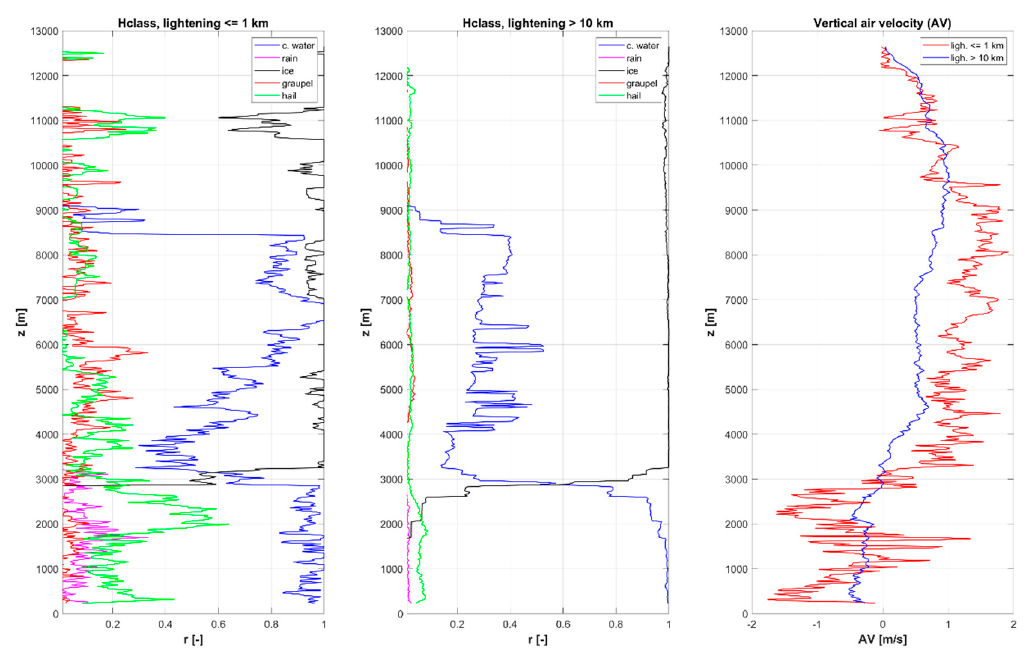
Figure 8 Vertical profile of the percentage ratio of the occurrence of hydrometeors (r [ − ]) during analyzed thunderstorms for: NL discharges (left panel) and far-lightning (FL) discharges (middle panel). Right panel depicts the vertical profile of air velocity (AV) oriented upwards from the cloud radar during the thunderstorms: red curve displays averages for NL discharges, while blue curve the averages for FL discharges. Note that y-axis (z [m]) represents the height in meters above the cloud radar situated at an elevation of 837 m a.s.l.